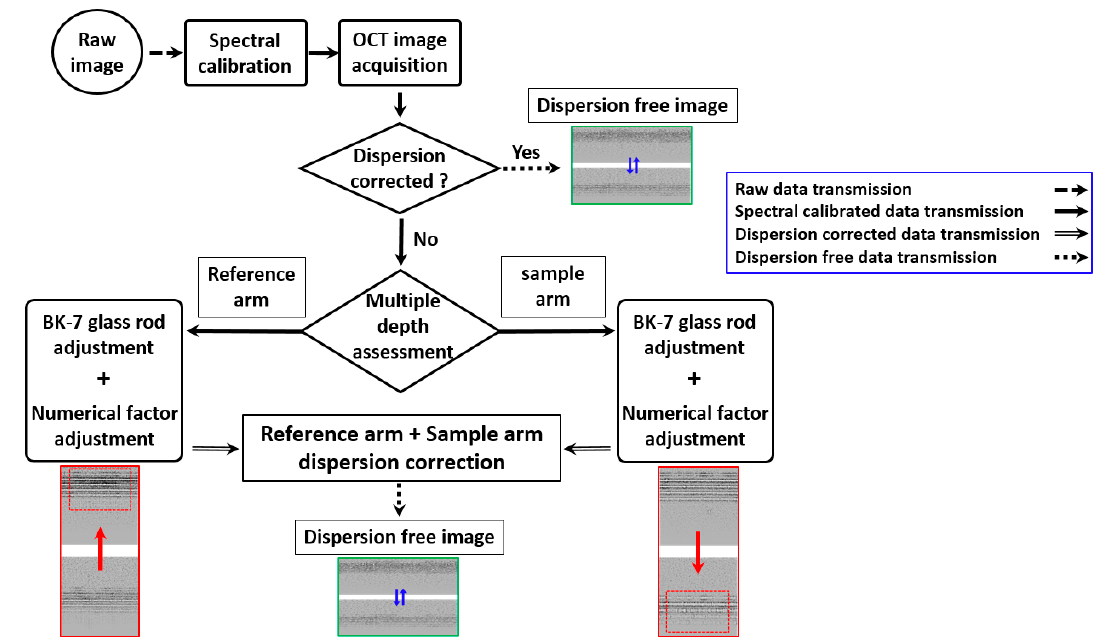
Figure 3. Flow diagram of the fundamental steps performed for dispersion of the system. The red color solid arrows illustrate switching image states (changing of images), while compensating dispersion using decoupled hardware and software methods. The blue color solid arrows illustrate switching image states, while changing the focusing position.